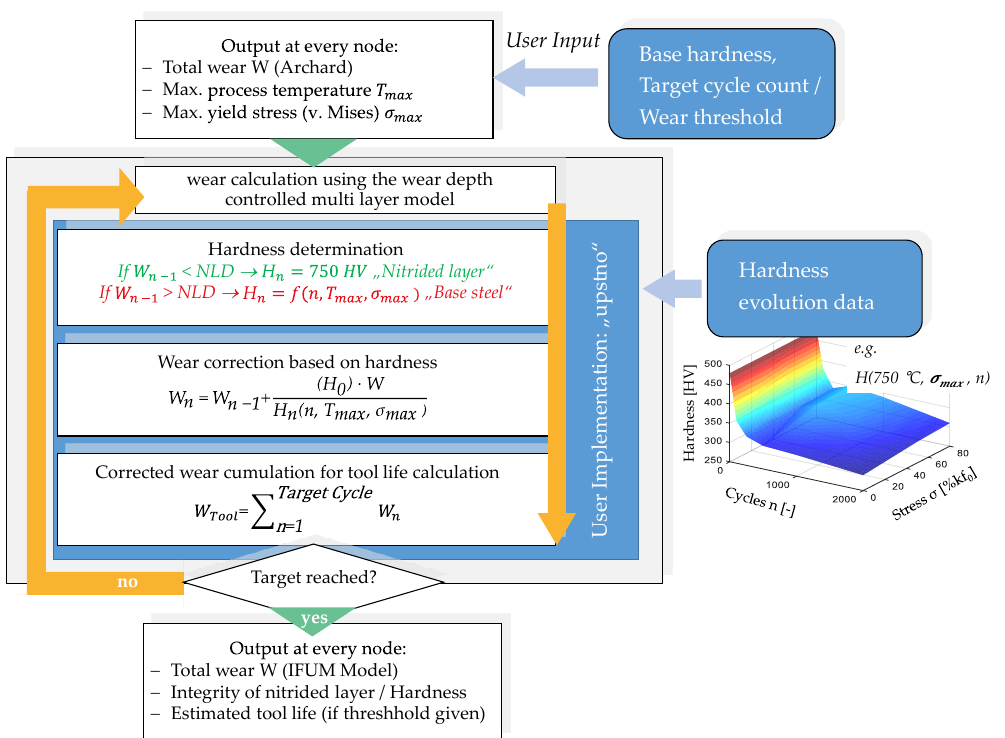
Figure 6. Hardness and wear model implementation during post-processing.